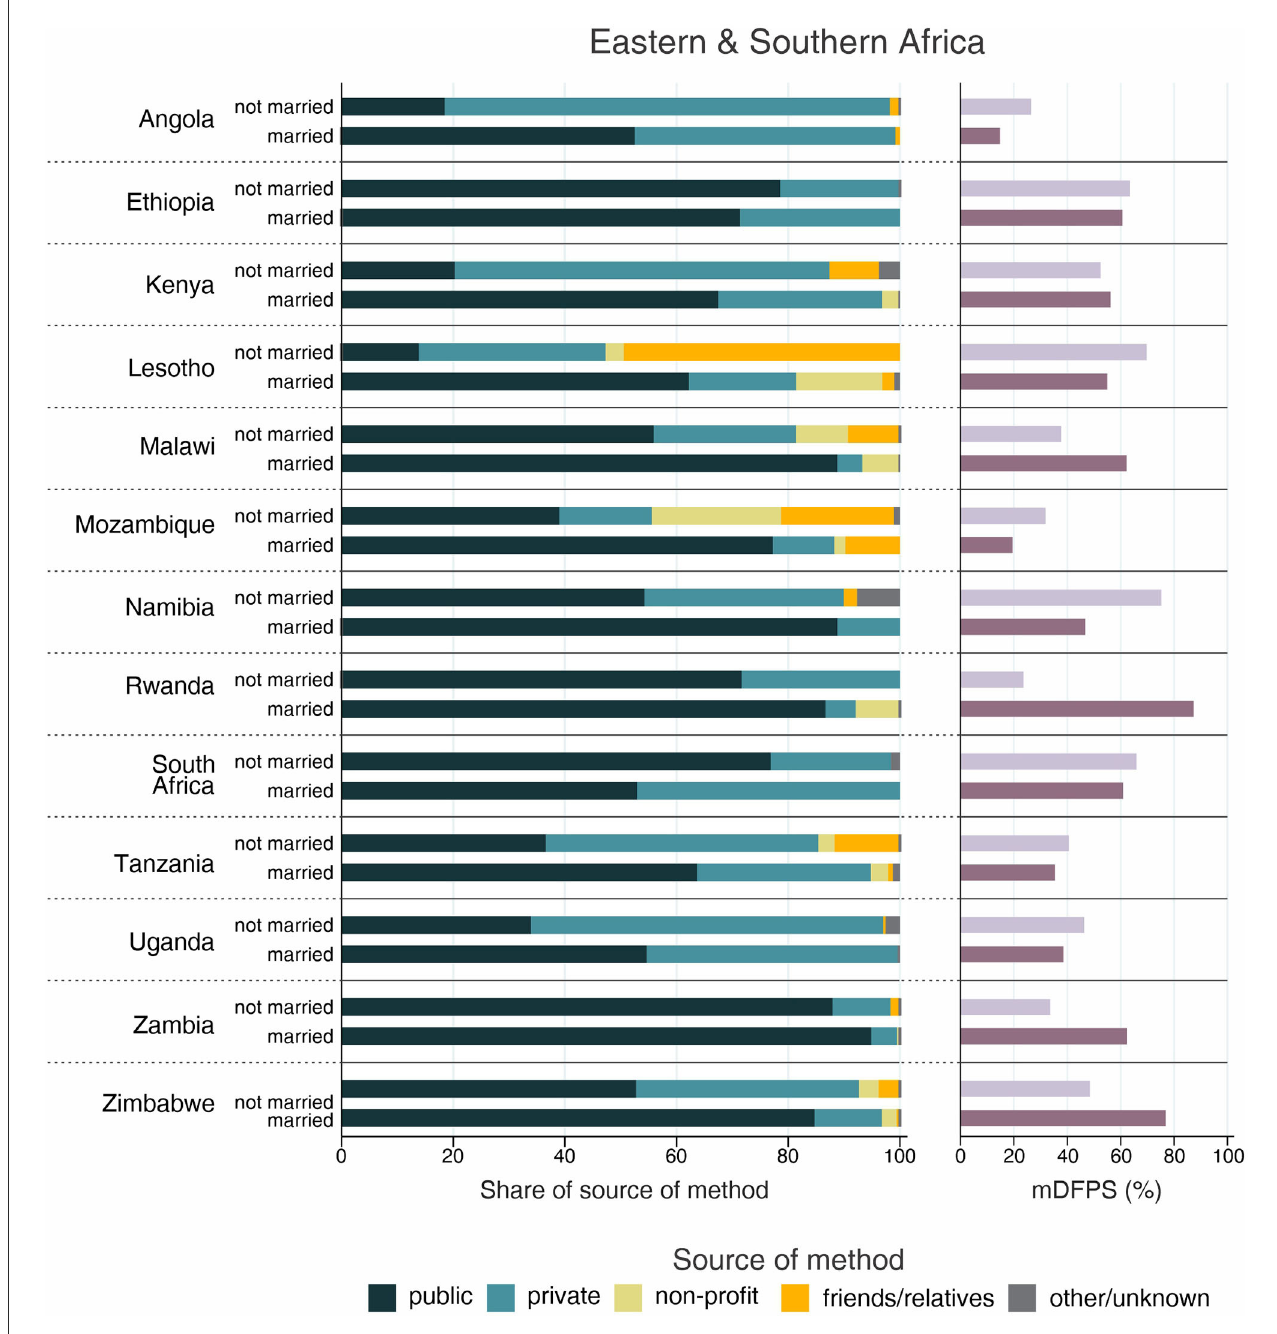
FIGURE6 Demand for family planning satisfied by modern methods (mDFPS) and share of source of method by adolescent’s marital status in Eastern and Southern Africa. Source: DHS, 2010-2021. Countries missing information on never married women or with fewer than 25 cases have been